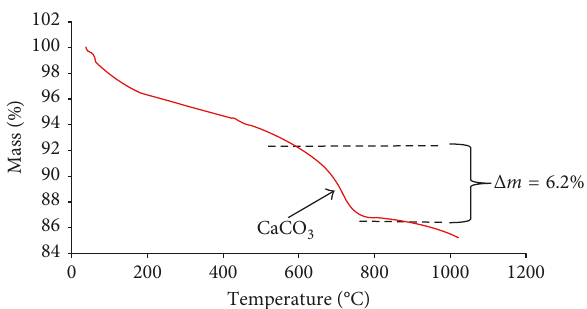
Figure 9: TGA curve of extracted powder out of healed crack in LSP-B